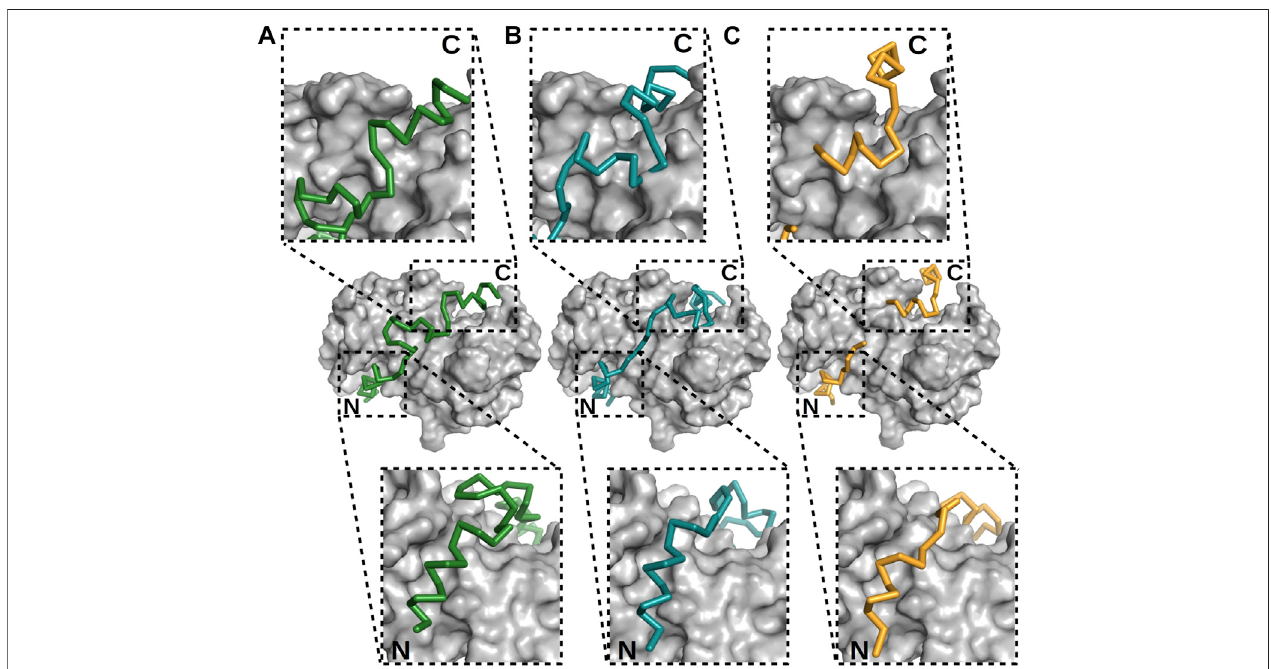
FIGURE 5 | Different modes of binding of p53 TAD to S100A4. (A, B) The two best models built, using NMR data (Dudás et al., 2020), and (C) X-ray crystal structure of the p53 TAD 17 – 56 – S100A4 complex (Ecsédi et al., 2020). p53 is shown as alpha-carbon traces in different colors, while S100A4 is shown as surface representations in gray. The labels N and C mark the locations of the N- and C-termini of the p53 peptide. The binding of the N-terminus is nearly identical in these three cases, but the C-terminus and the linker connecting the ordered regions differ, showing the different binding modes of p53. In the crystal structure determination, parts of the linker were not visible, indicative of its fl